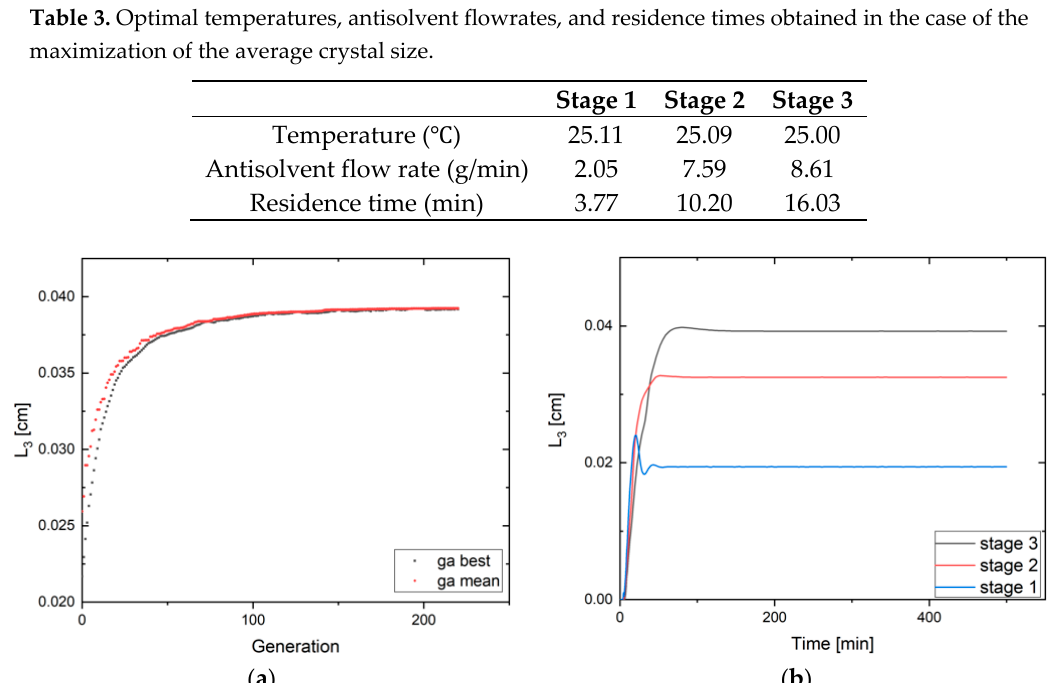
Figure 2. ( a ) Performance of the genetic algorithm showing the mean and best results of the objective function at different generations. ( b ) Optimal mean crystal size at different MSMPR